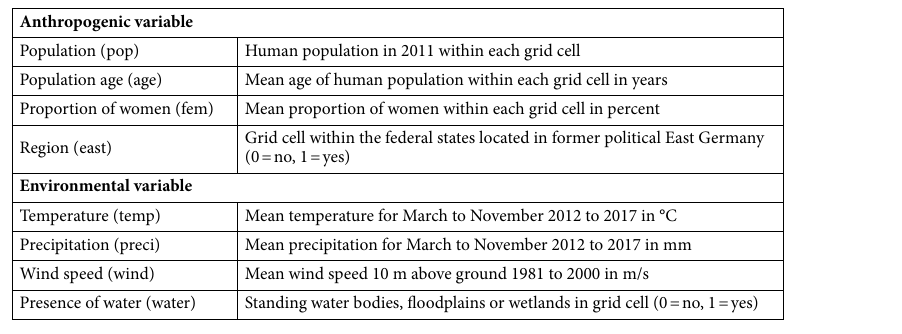
Table 1. Set of variables pre-selected as